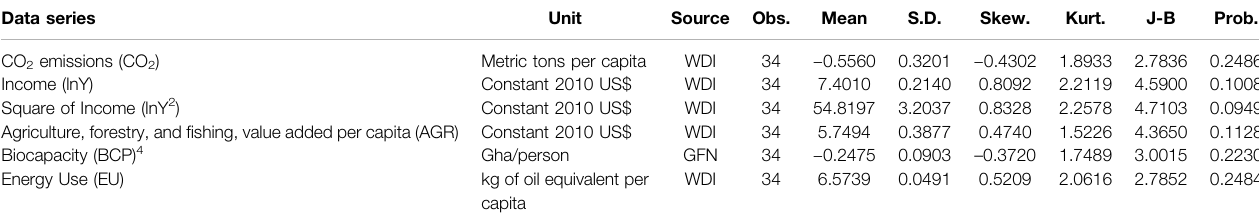
TABLE 1 | Features of data series using descriptive statistics. Data